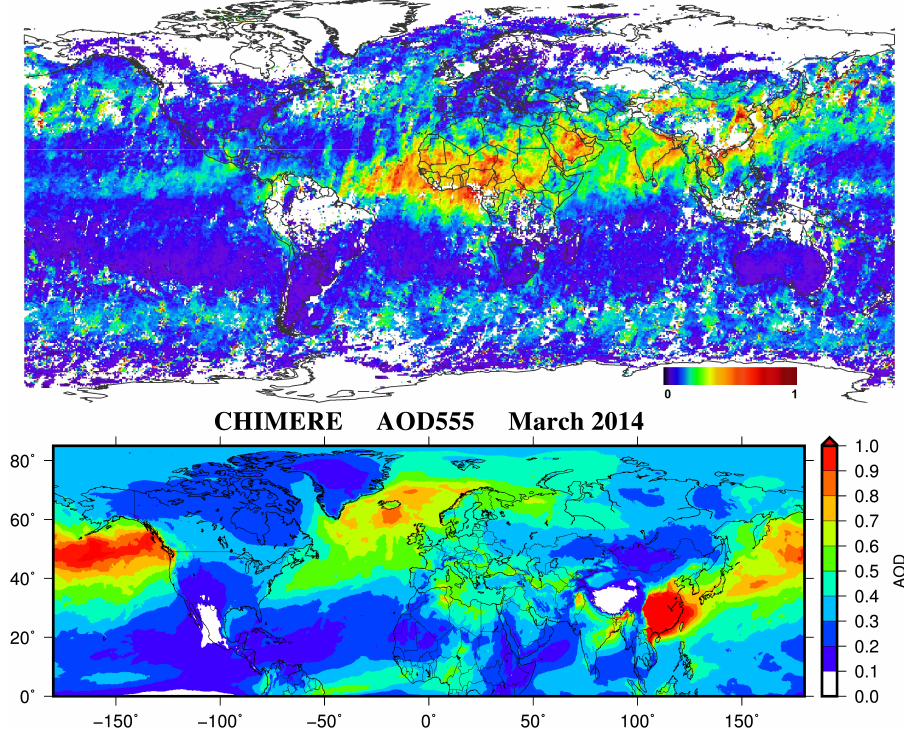
Figure 9. ( Top) MISR (on board TERRA satellite instrument) monthly mean AOD 555 nm for March 2014 with cloud screening; and ( Bottom ) mean AOD 555 nm simulated by CHIMERE without cloud